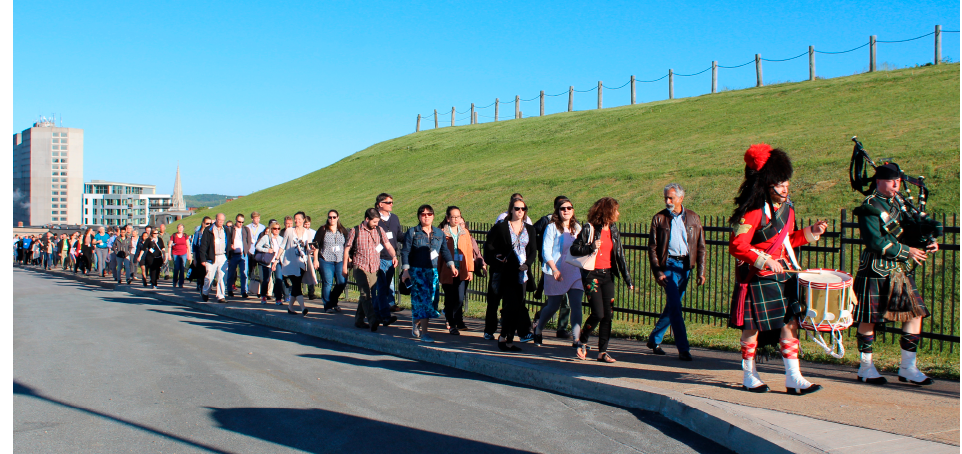
Figure 6. CSV2018 attendees led to the Halifax Citadel National Historic Site. Two members of the 78th Highlanders Regiment ascend Citadel Hill while playing pipe and drum, with symposium attendees in tow.